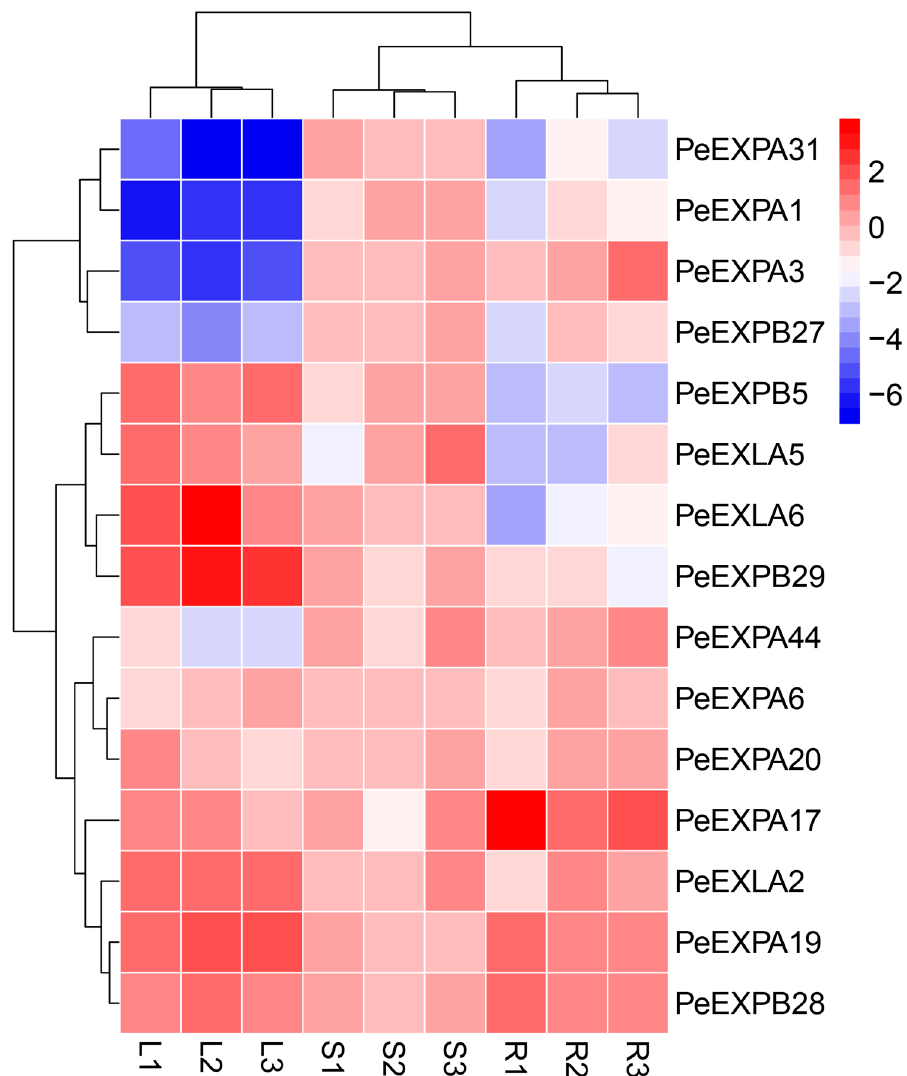
Figure 8. Expression pattern of 15 selected PeEXs in di ff erent tissues. The heat map was drawn using log2 logarithmic transformed expression values. Red and blue represent high and low expression levels, respectively. Based on the expression, the expansin genes were hierarchically clustered and divided into various gene clusters in the figure. L, leaves; S, stems; R, roots; 1, 2 and 3 represent the three biological replicates. Three repetitions were used to reduce technical errors when performing